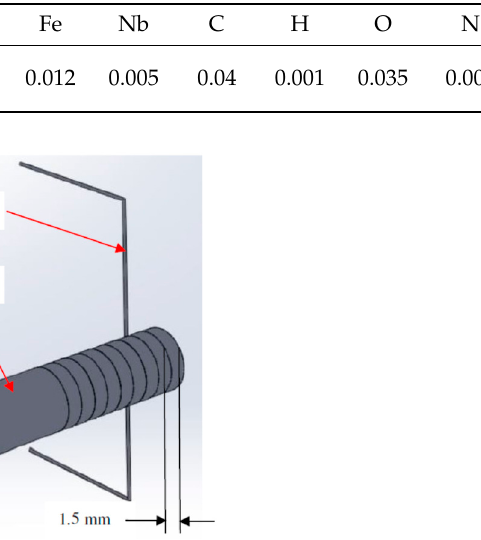
Table 1. Chemical composition (wt.%) of Nitinol.